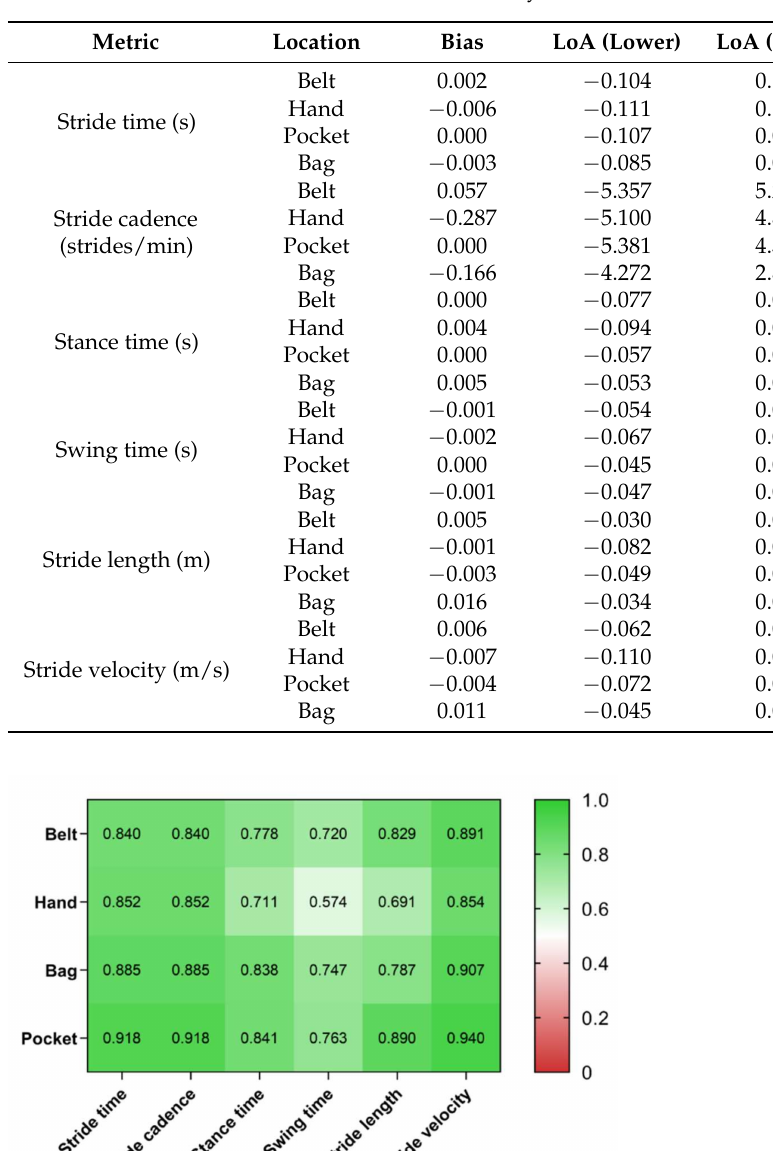
Table 6. Agreement between gait parameters measured in the pants pocket and other smartphone locations. Bias and LoA from the Bland-Altman analysis are shown.